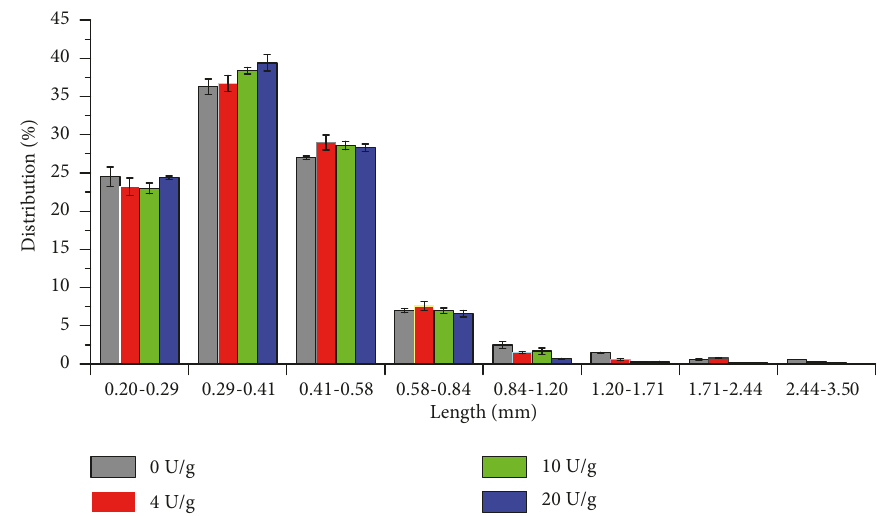
Figure 5: Effect of xylanase treatment on the length distribution of refiner mechanical fibers.